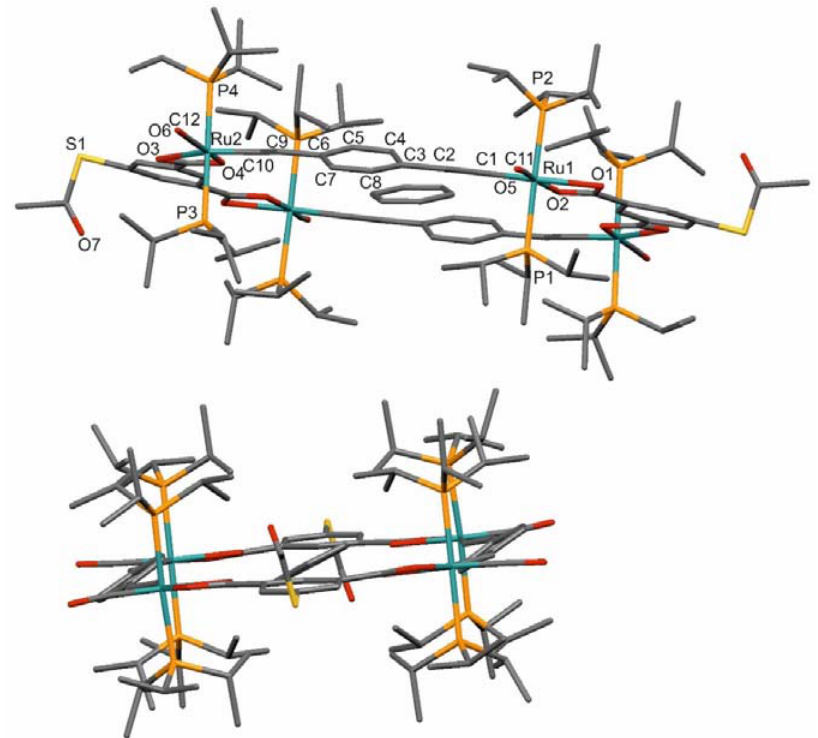
Figure 4. Two different views of an individual molecule of 4 with the benzene solvate molecule incorporated into the central cavity. Selected bond lengths in Å: Ru1–P1: 2.398(4), Ru1–P2: